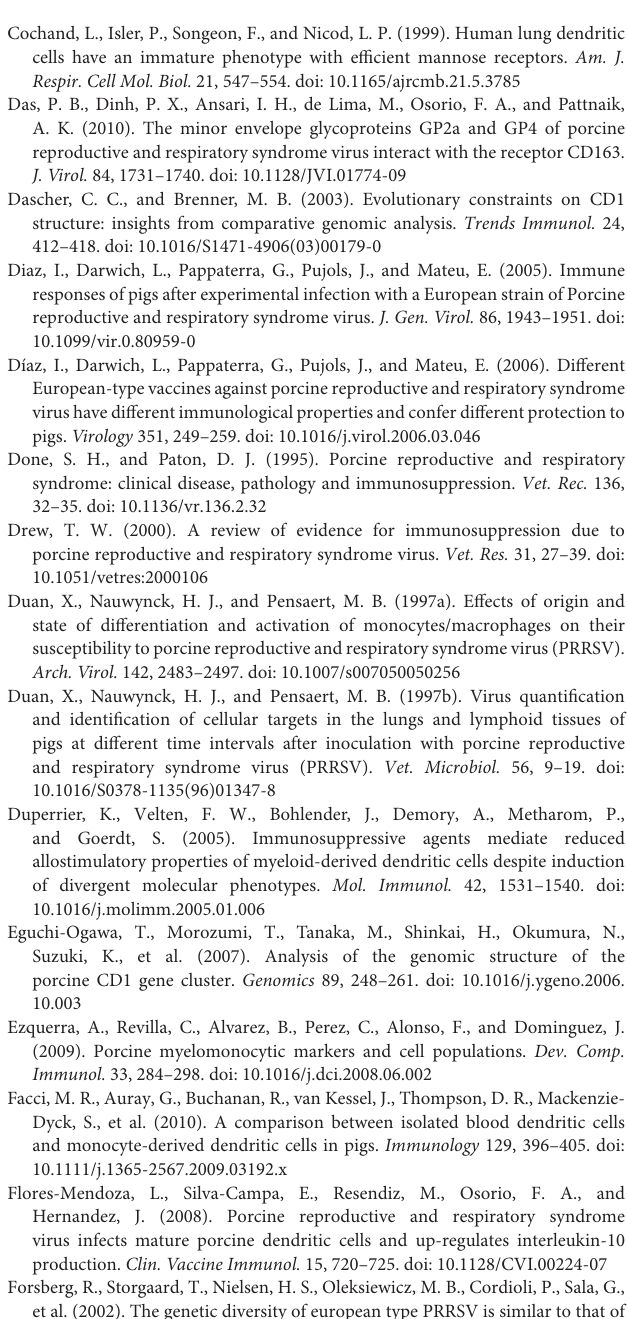
stain (B) . For negative controls, cells were stained with secondary G1-APC* only (C) and with a mouse IgG1 isotype and secondary G1-APC* (D) . SDOW-APC* staining is shown in mock infected MoMØs (E) and in unstimulated (F) , M1 (G) , M2 (H) , dexa (I) , IL-10 (J) treated MoMØs. Data are representative of three independent experiments. FIGURE S7 | Morphology of MoDCs. Four-day-old MoDCs were either left untreated, (A) , or treated for 24 h with a maturation cocktail containing LPS, IFN- γ , IL-6, TNF- α , IL-1 β , and PGE 2 (B) . Alternatively, four-day-old MoDCs were treated for 24 h with IL-10 (C) or dexa (D) . Light microscopy photographs are representative of three independent experiments. Magnification is 20 ×